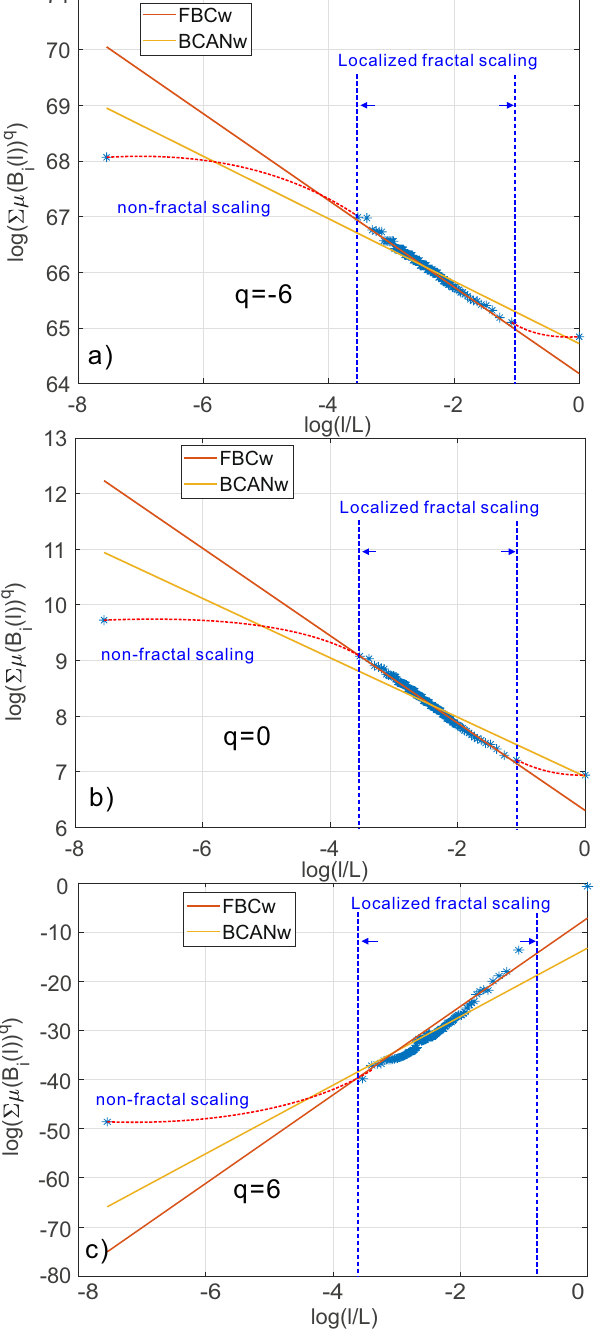
Figure 13. The failure of BCANw to capture the localized fractal scaling of collaboration network over a finite range of network scales. In the case of real world networks, the self-similar property does not holds at all scales of networks. There might exist a finite range of scales where fractal scaling behavior dominates. Moreover, this phase transition phenomenon consistently holds under all distorting factor q , suggesting a localized multi-